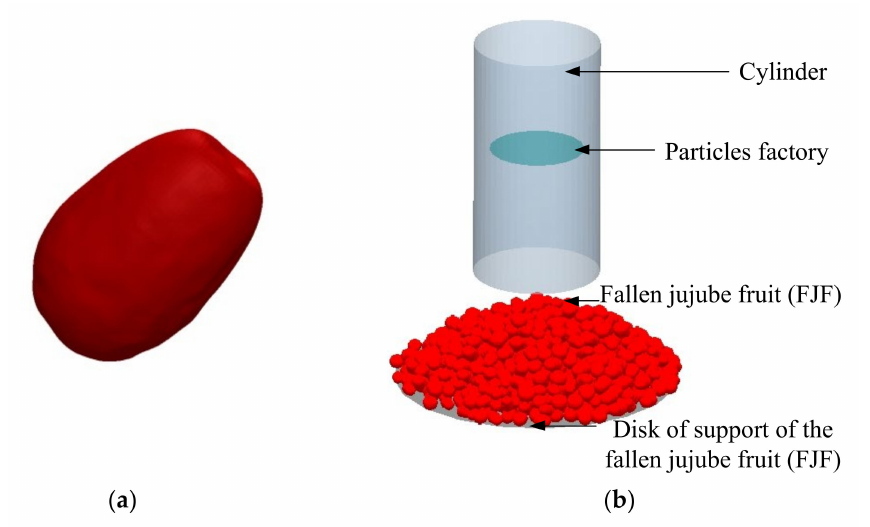
Figure 5. The simulation model and simulation angle of repose test; ( a ) 3D model of fallen jujube fruit (FJF) obtained by three-dimensional scanning, ( b ) test process of the simulation angle of